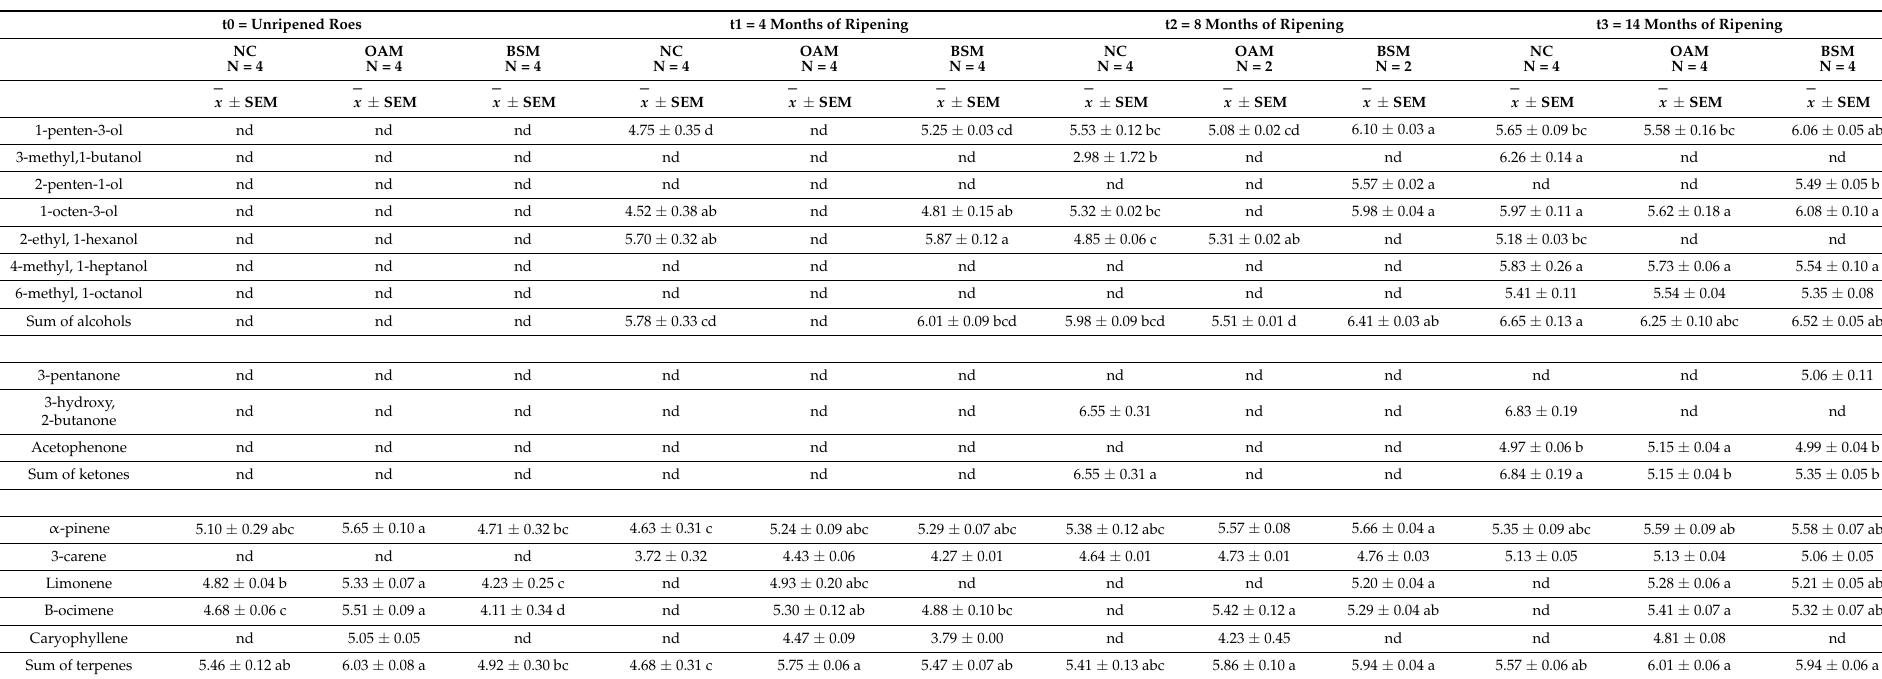
Table 4. Alcohols, ketones and terpenes detected in caviar during the ripening time. Chromatographic areas are expressed in Log10. Data are presented as mean ( x ) ± the standard error of the mean (SEM). Legend: NC, sodium chloride (NaCl); OAM, organic acid mixture; BSM: borax and salt